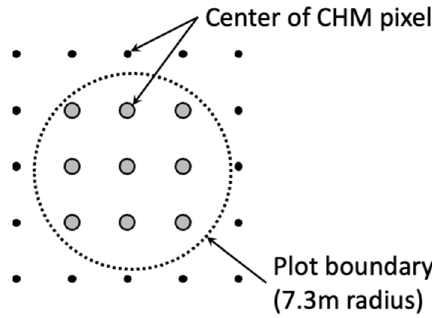
Figure 7. Extraction of plot-level maximum tree height using canopy height model (CHM). The maximum canopy height was derived by searching inside a continuous forest inventory (CFI) plot area (r = 7.32 m).